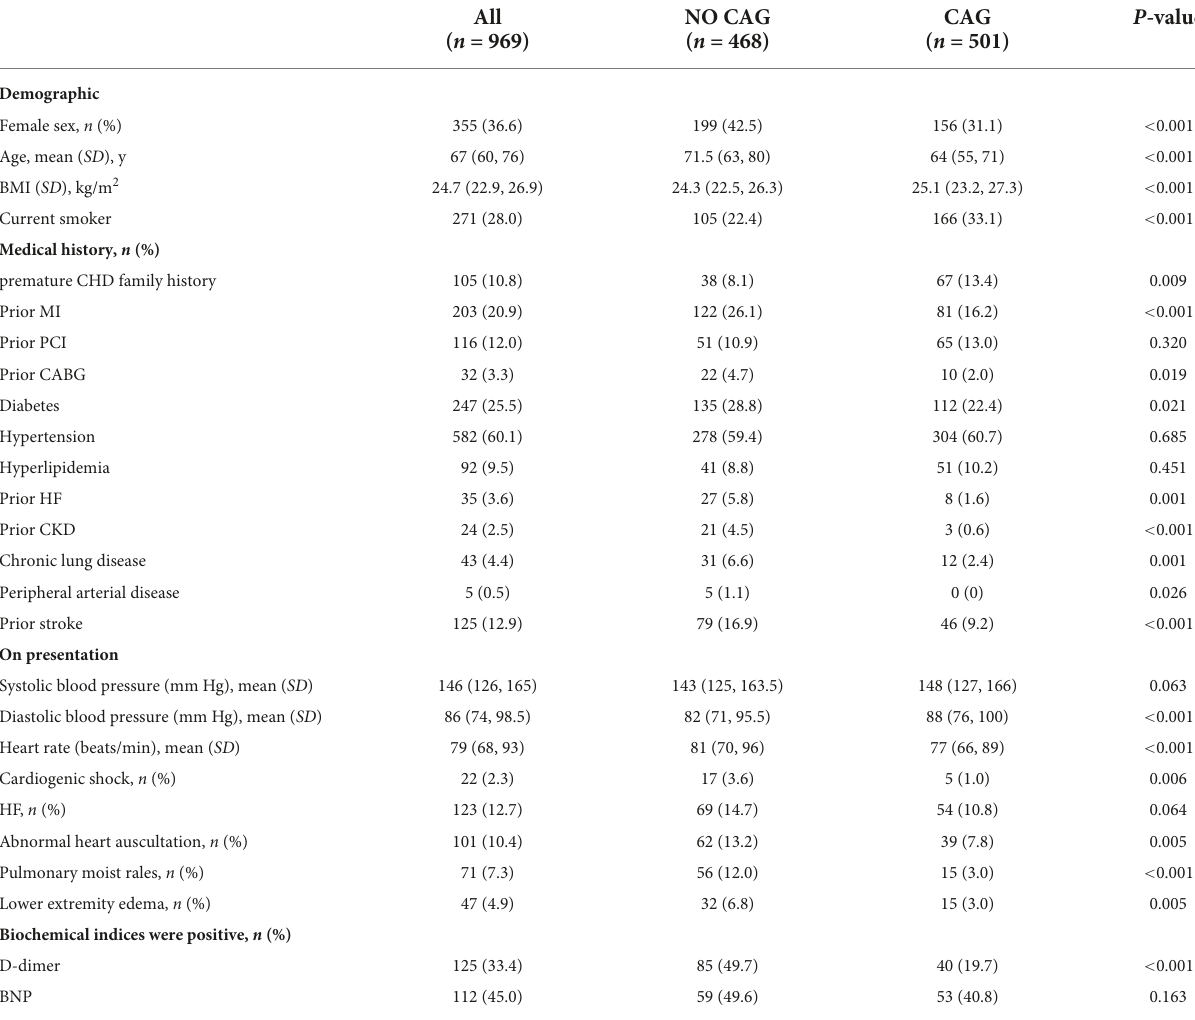
TABLE 1 Baseline clinical characteristics for NSTEMI